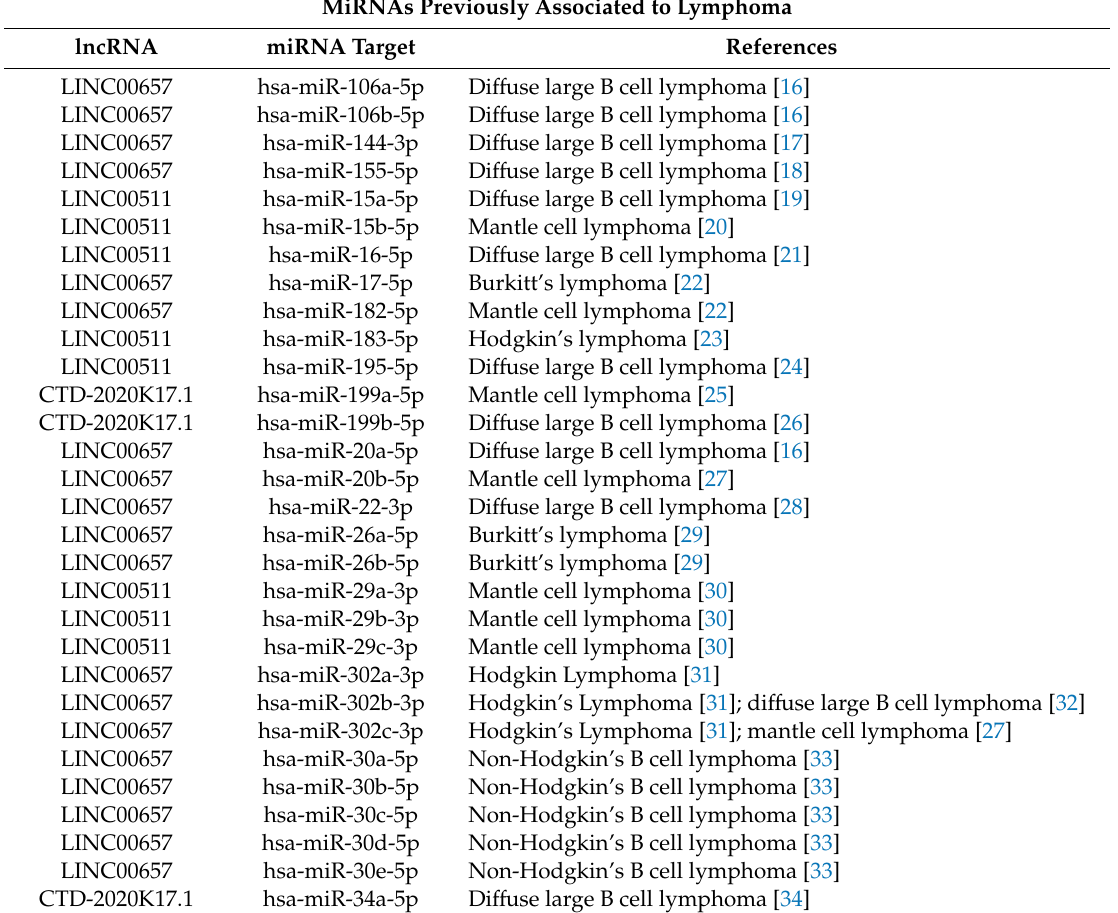
Table 3. miRNA targets of the selected lncRNAs that have been associated to lymphoma and / or pSjS. MiRNAs Previously Associated to Lymphoma lncRNA miRNA